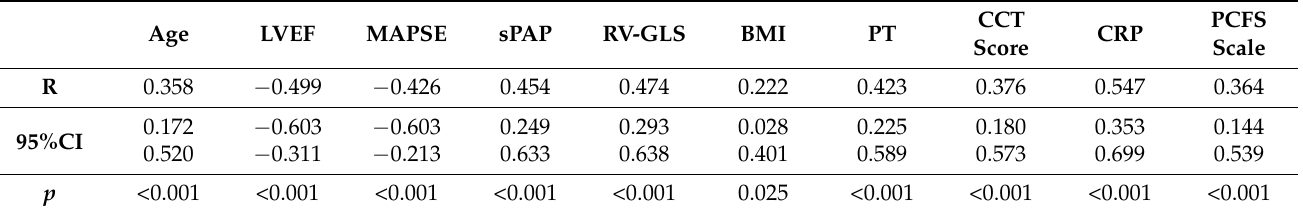
Table 4. Correlations between E/e’ other TTE parameters and laboratory data in study